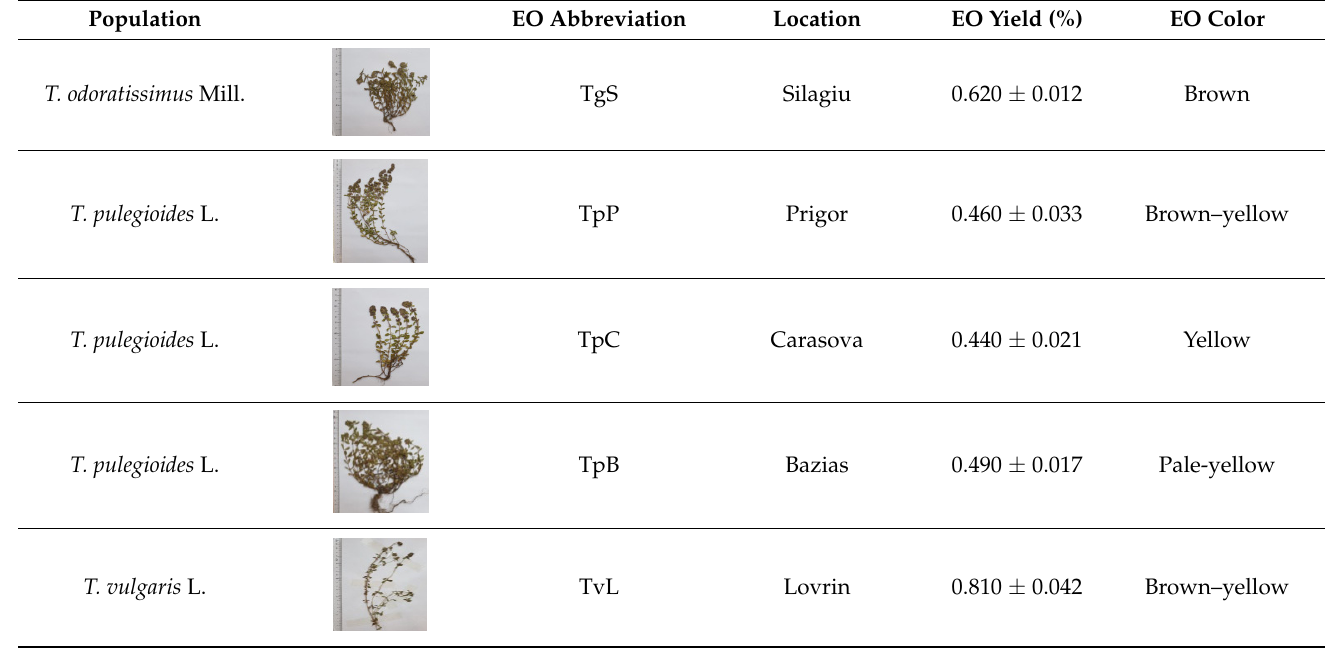
Table 1. The yield and color of the EOs isolated from the aerial part of Thymus populations collected from five areas in Banat. Population